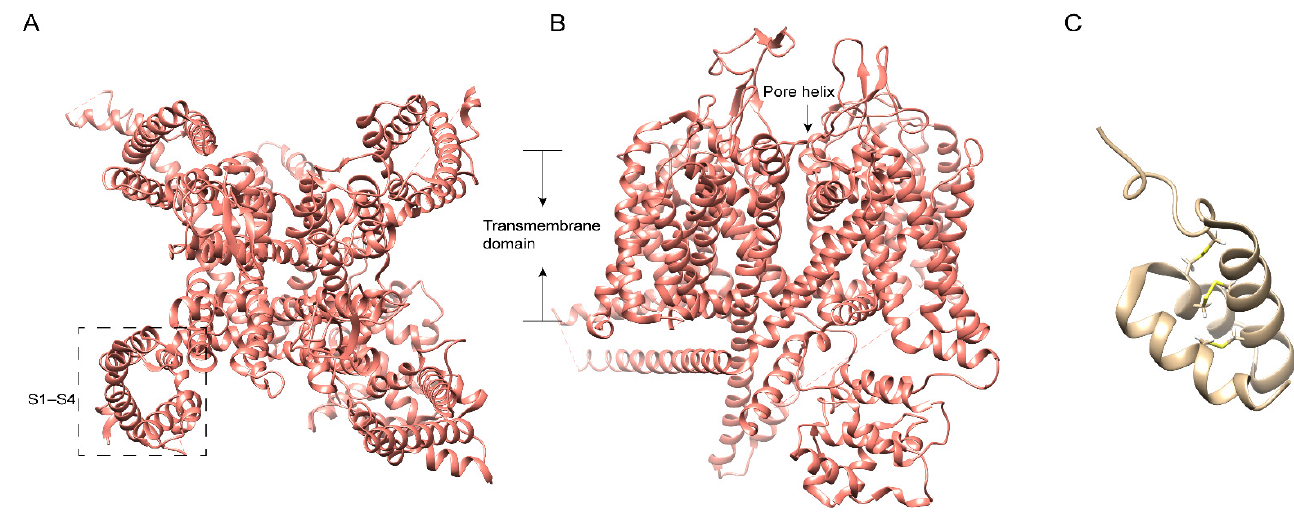
Figure 2. Structures of N-type voltage-gated calcium channels (Cav2.2) and centipede venoms. Ribbon diagram of the Cav2.2 atomic model (PDB id: TMIY) showing views from the bottom ( A ) and side ( B ). The voltage-sensing domain is labeled with the dashed box. The membrane-spanning helices of the Cav2.2 channel are indicated. ( C ): k-Ssm1a from Scolopendra subspinipes . PDB id: 2M35.